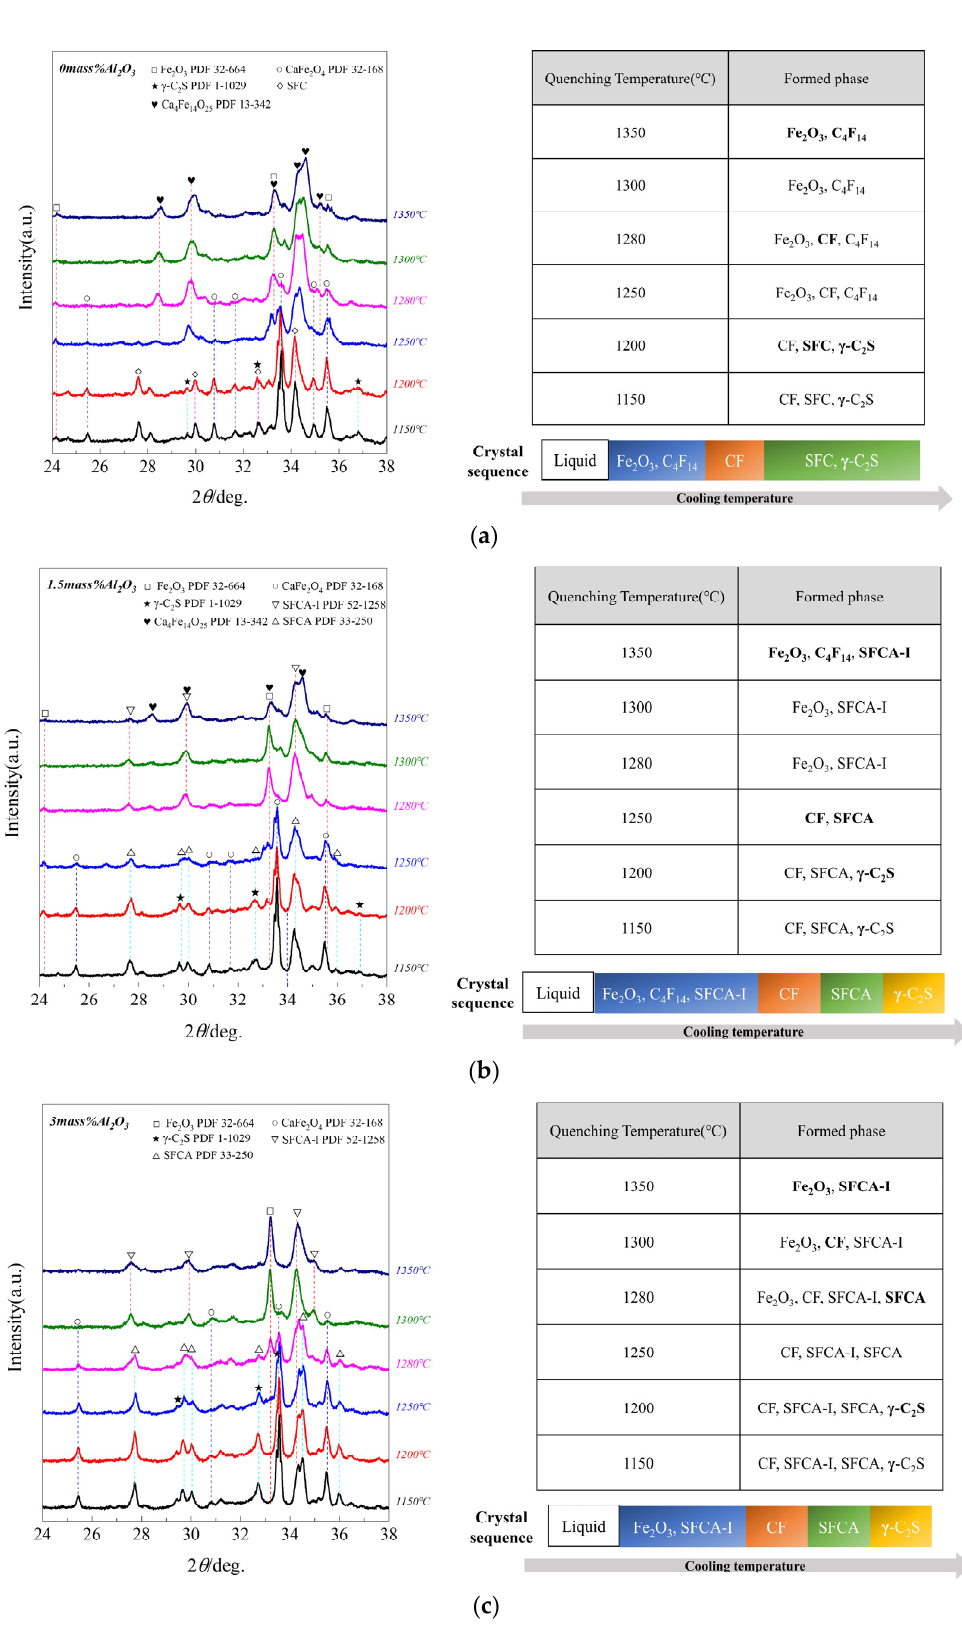
Figure 5. XRD patterns of water-cooled (65 °C/s) samples at different target temperatures ( a ) 0 mass% Al 2 O 3 ; ( b ) 1.5 mass% Al 2 O 3 ; ( c ) 3 mass% Al 2 O 3 . (The bold contents were the first formed phases in the corresponding temperature) (1) When Al 2 O 3 was not added, the crystalline phase of quenched samples was Fe 2 O 3 and C 4 F 14 at 1350 °C, while Fe 2 O 3 and C 4 F 14 increased at 1300 °C, simultaneously CF appeared; Fe 2 O 3 and C 4 F 14 increased at 1280 °C, while Fe 2 O 3 decreased. CF increased at 1250 °C, simultaneously SFC and γ -C 2 S appeared while Fe 2 O 3 disappeared; CF increased at 1200 °C, and CF, SFC, and γ -C 2 S increased at 1150 °C. So it can be considered the crystallization sequence was (Fe 2 O 3 , C 4 F 14 ) → CF → (SFC, γ -C 2 S). (2) When Al 2 O 3 reached 1.5 mass pct, the crystalline phase of quenched samples was Fe 2 O 3 and C 4 F 14 at 1350 °C; SFCA- Ι appeared, simultaneously Fe 2 O 3 increased at 1300 °C, but C 4 F 14 disappeared; Fe 2 O 3 and SFCA- Ι increased at 1280 °C; SFCA and CF appeared at 1250 °C, simultaneously Fe 2 O 3 and SFCA- Ι decreased. At this time, SFCA was formed by the preferentially precipitated SFCA-I and Al 3+ and Si 4+ in the melt; CF and SFCA increased at 1200 °C, simultaneously γ -C 2 S appeared; CF, SFCA, and γ -C 2 S increased at 1150 °C. So it can be considered the crystallization sequence was (Fe 2 O 3 , C 4 F 14 ) → SFCA-I → CF → SFCA → γ -C 2 S. (3) When Al 2 O 3 reached 3.0 mass pct, the crystalline phase of quenched samples was Fe 2 O 3 and SFCA- Ι at 1350 °C; SFCA- Ι increased while Fe 2 O 3 decreased, simultaneously CF appeared at 1300 °C; Fe 2 O 3 and SFCA- Ι decreased at 1280 °C while CF increased, simultaneously SFCA appeared; CF and SFCA increased at 1250 °C while SFCA- Ι decreased, simultaneously Fe 2 O 3 disappeared; SFCA- Ι decreased at 1200 °C while CF and SFCA increased, simultaneously γ -C 2 S appeared; SFCA- Ι decreased at 1150 °C while CF, SFCA, and γ -C 2 S increased. So it can be considered the crystallization sequence was (Fe 2 O 3 , SFCA-I) → CF → SFCA → γ -C 2 S. Thermodynamically, the Gibbs free energy of formation of C 2 S is lower than that of CF [27], and the reactions are as Equations (1) and (2), respectively. It shows that C 2 S is more stable to form easier than CF. However, since the added SiO 2 content of 4mass pct is much smaller than Fe 2 O 3 , resulting in the probability of Si 4+ reacting with Ca 2+ is relatively small, simultaneously Si 4+ also participates in the formation of SFC, SFCA-I, and SFCA. Therefore, the crystallization sequence of C 2 S was late. Since the Gibbs free energy of C 4 F 14 , SFC, SFCA-I, and SFCA formations are not existing in the thermodynamic database, unfortunately it cannot be compared with other crystalline phases. 2CaO + SiO 2 = 2CaO·SiO 2 ∆ f G m θ = − 118899 − 11.3T (J/mol)